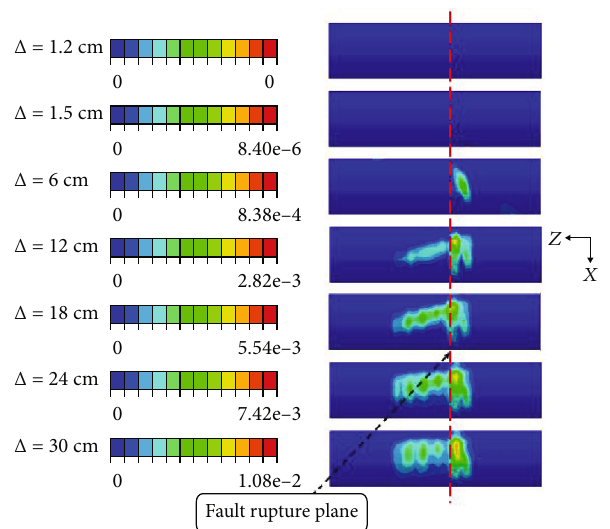
Figure 7: PQQE development